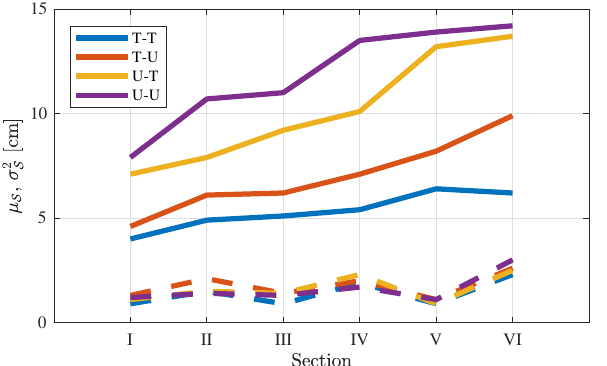
Figure 7. Path difference (solid lines) and variance (dashed lines) by large intestine section, S , averaged over all